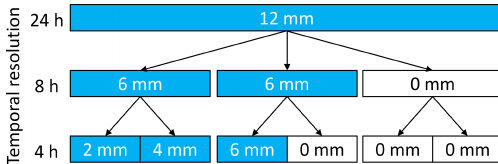
Figure 6. General scheme of the cascade model for the first two disaggregation steps with exemplary rainfall amounts for a daily total of 12mm (blue boxes show wet time